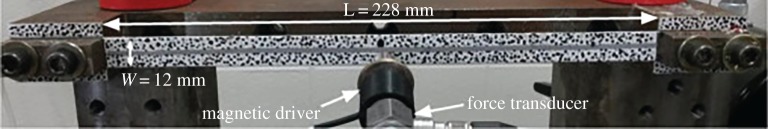
The experimental set-up for constructing backbone curves for a clamped–clamped beam. Adapted from [21]. (Online version in colour.)